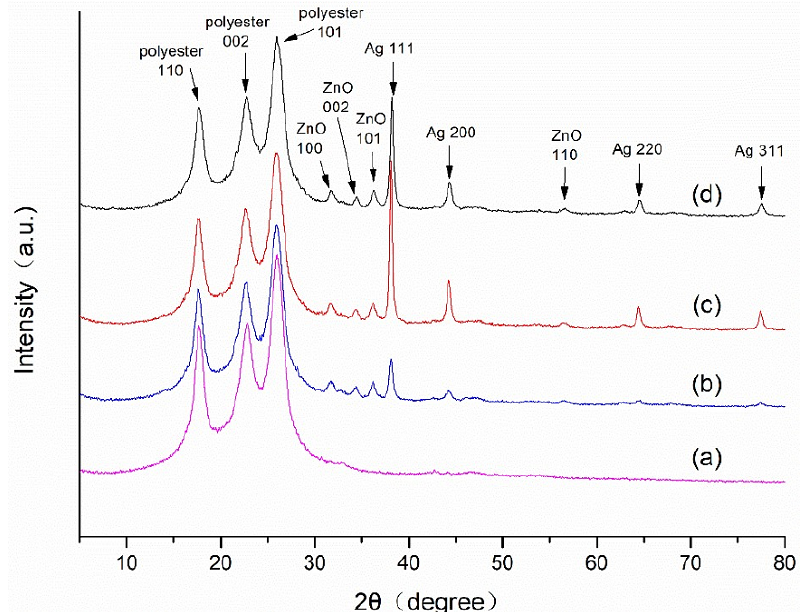
Figure 2. X-ray diffractometer (XRD) patterns of ( a ) polyester nonwoven; ( b ) ZnO/Ag composite coated polyester nonwoven (3#); ( c ) ZnO/Ag composite coated polyester nonwoven (4#); and ( d ) ZnO/Ag composite coated polyester nonwoven